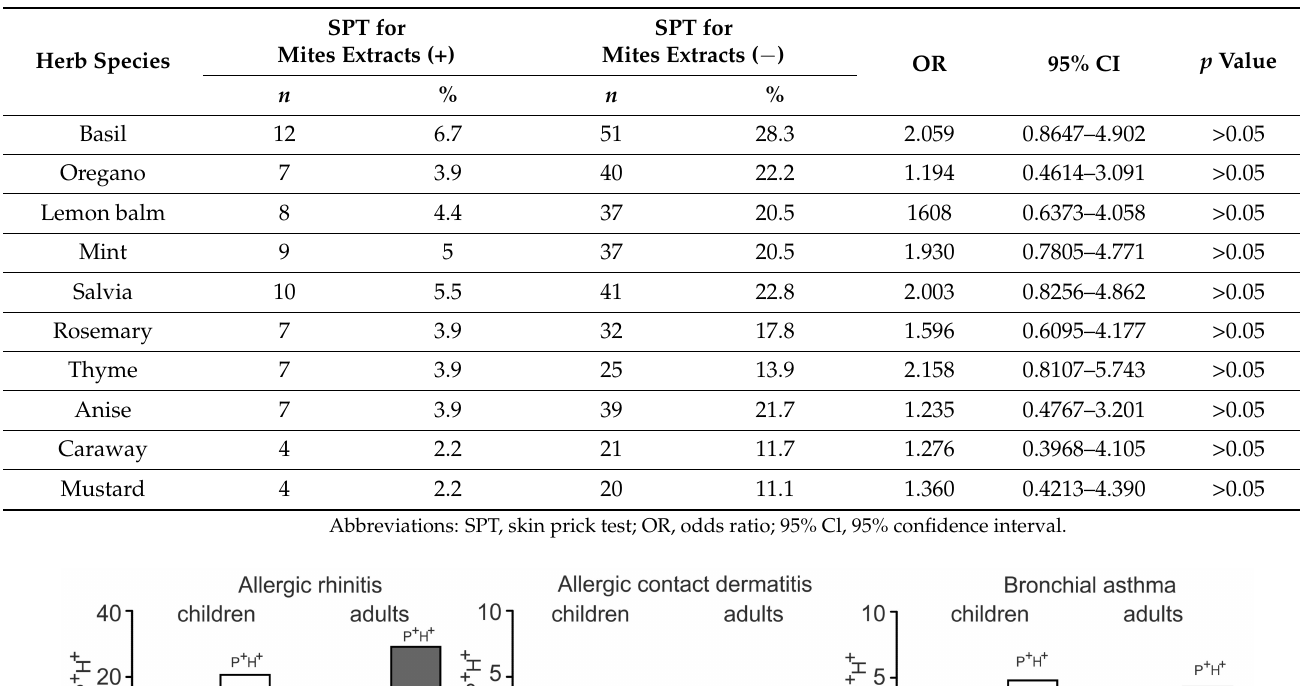
Table 4. Incidence and odds ratio (OR) of positive SPT ( Φ ≥ 3 mm) for particular herbs in relation to positive (+) or negative ( − ) SPT for mite extracts.